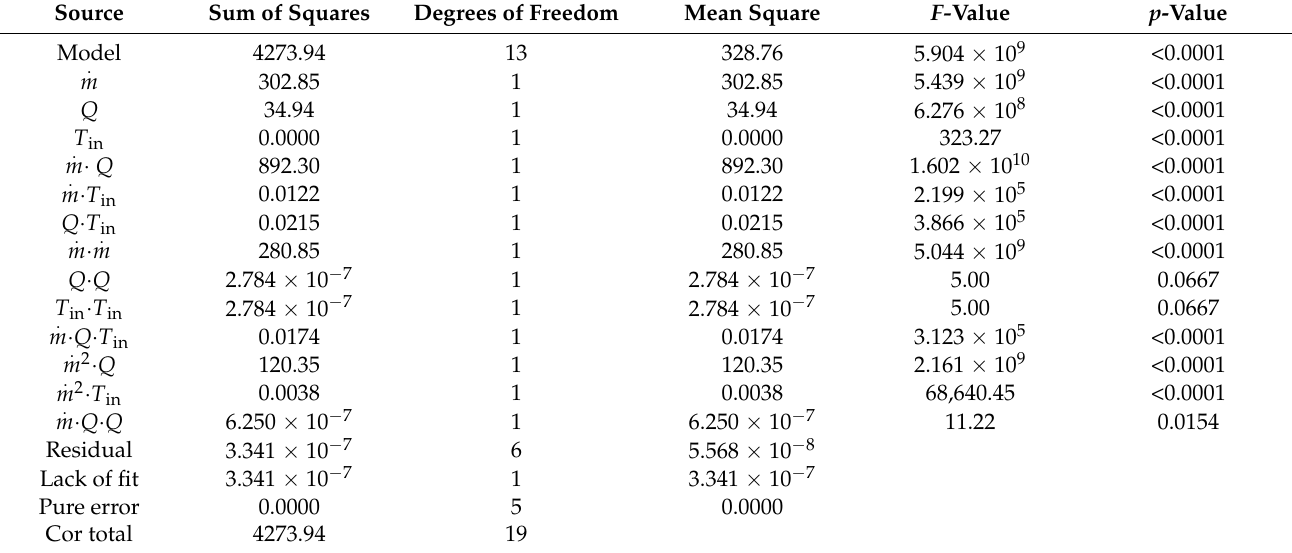
Table 5. The ANOVA for the maximum temperature difference (before